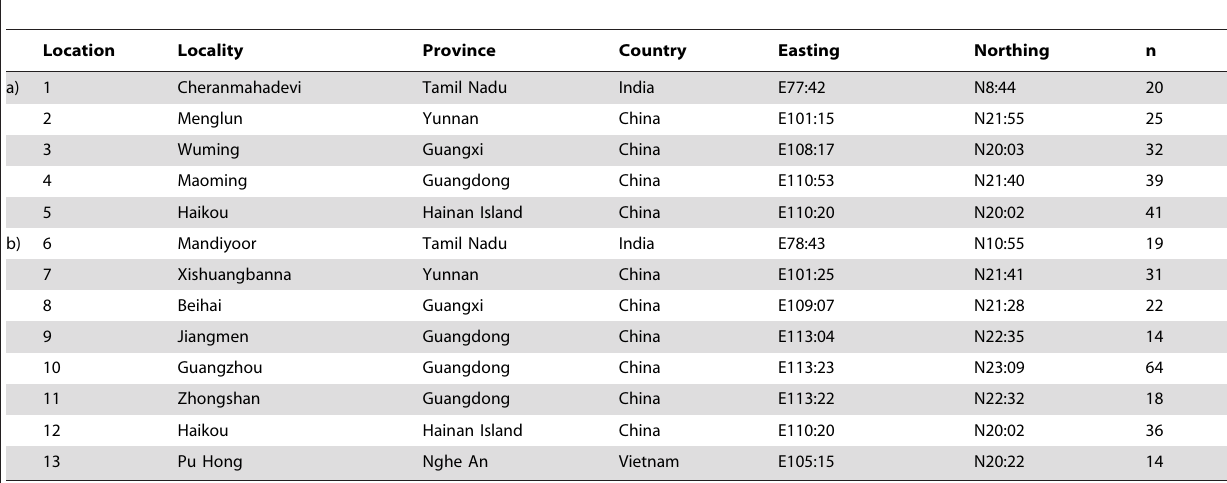
Table 1. Details of sampling locations in a) five populations of Rousettus leschenaulti and b) eight populations of Cynopterus sphinx